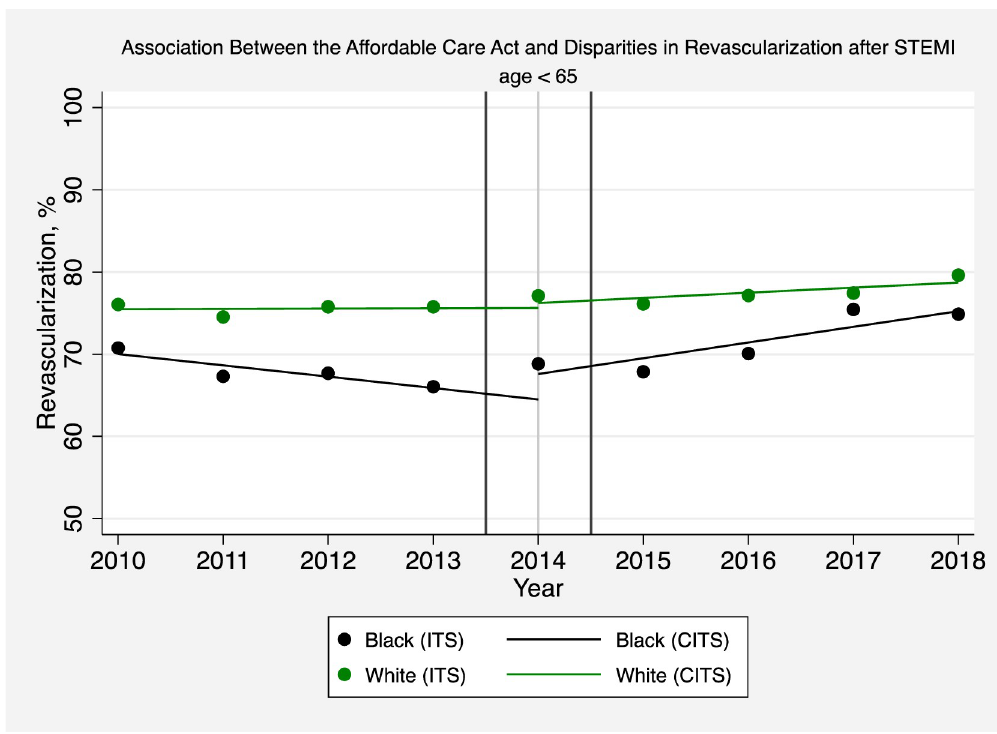
Fig 2. Association between the affordable care act and disparities in revascularization after STEMI (age < 65). The solid circles represent the yearly estimates for the revascularization rate in black and white patients hospitalized with a STEMI based on an interrupted time series (ITS) model after adjusting patient-level and hospital effects, without imposing restrictions on time trends and making no assumptions that time effects were different before or after 2014. The solid lines are based instead on a comparative interrupted time series (CITS) model which assumes that pre-intervention and post- intervention trends are linear in order to interpret changes in revascularization rates before and after Medicaid